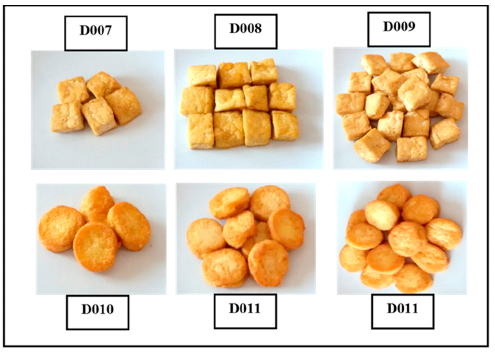
Figure 3. Food models for foodscape preferences—shape criterion (for carbohydrates).